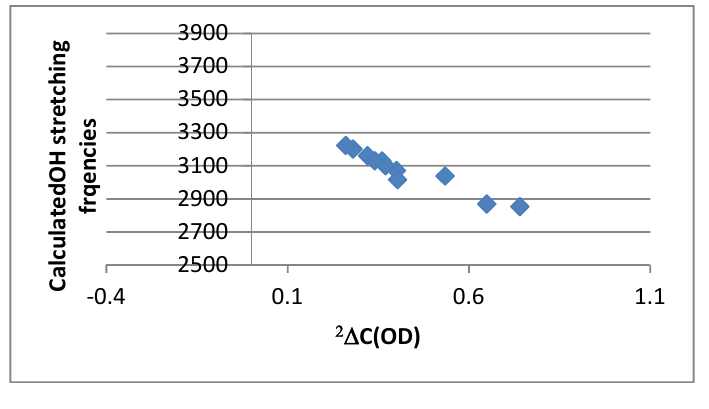
Figure 8. Plot of Calculated OH stretching frequencies vs. 2 